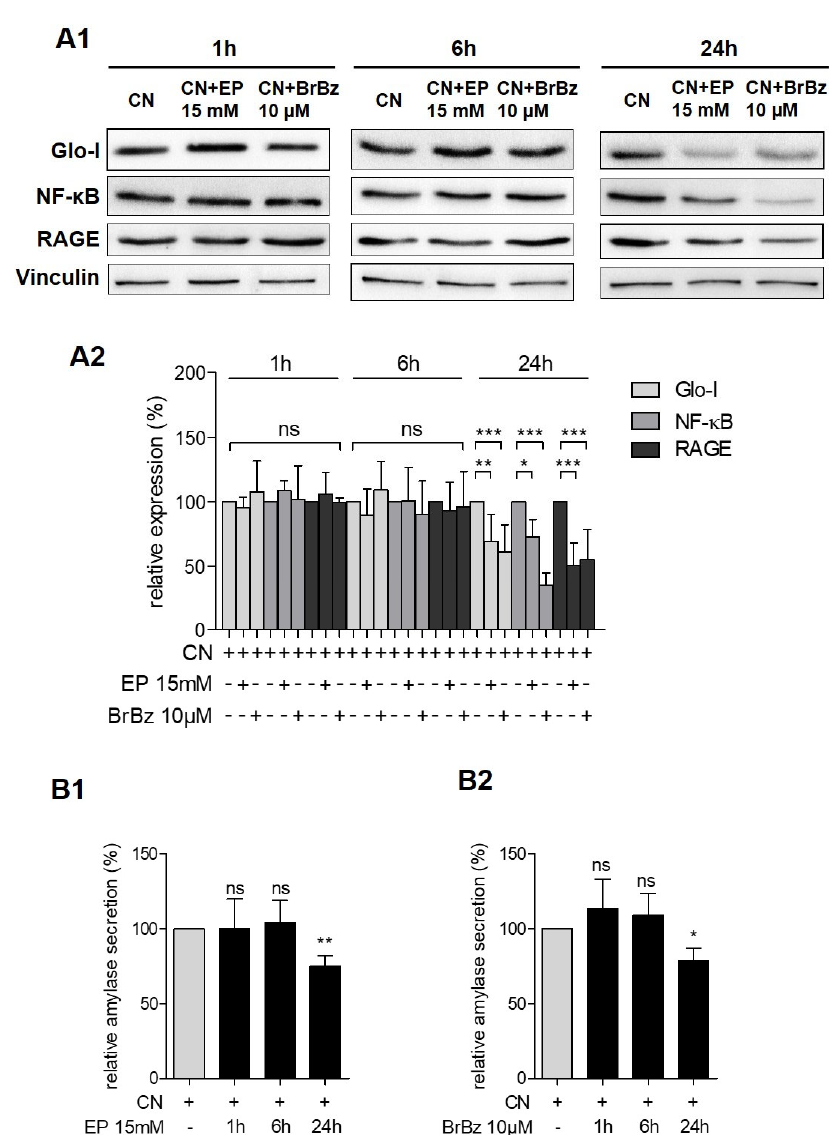
Figure 4. Effect of pharmacological Glo-I modulation on CN treatment. ( A1 , A2 ) Effects of EP and BrBz on CN-induced expression of Glo-I, NF- κ B and RAGE. AR42J cells were pretreated with dexa for 48 h. Another treatment with dexa and 15 mM of EP or 10 µ M of BrBz with CN showed no effects after 1 or 6 h of incubation. After 24 h, both EP and BrBz significantly reduced the expression of Glo-I, NF- κ B and RAGE. Representative images are shown in ( A1 ) and quantifications in ( A2 ). ( B1,B2 ) Impact of co-treatment of EP or BrBz and CN on amylase secretion of AR42J cells.